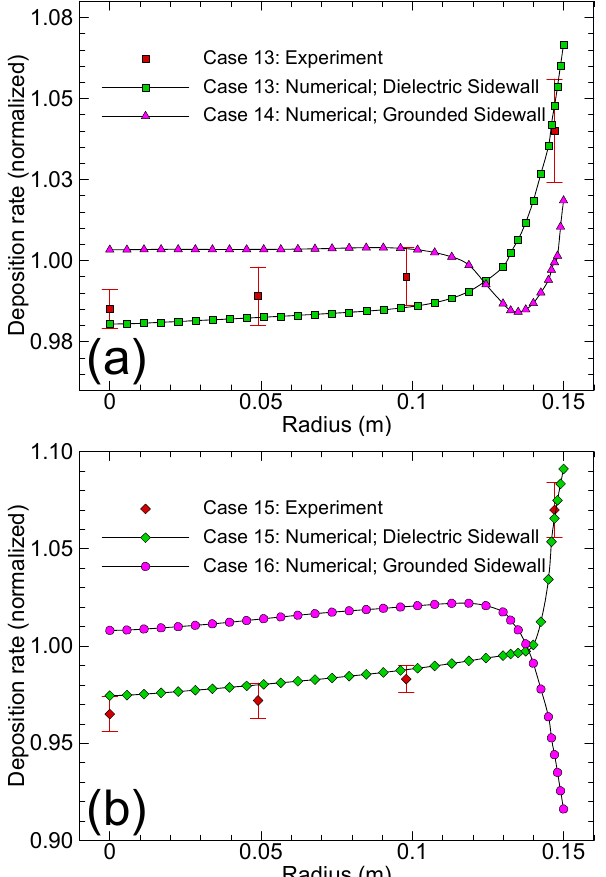
Figure 15. Effect of the sidewall and the gas pressure on the deposition rates. ( a ) The deposition rate profiles of Cases 13 and 14 are compared. Experimental data from Case 13 are superimposed on the profile of Case 13. ( b ) The deposition rate profiles of Cases 15 and 16 are compared. Experimental data from Case 15 are superimposed on the profile of Case 15. The profiles are normalized with their corresponding averaged values.